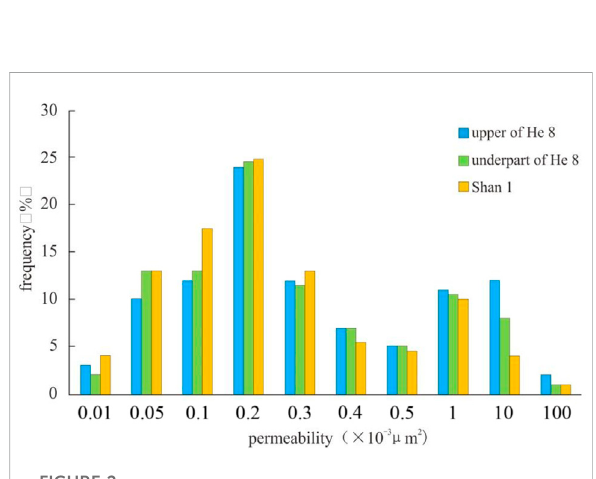
FIGURE 2 ReservoirpermeabilitydistributionhistogramfortheSuligegas fi eld.